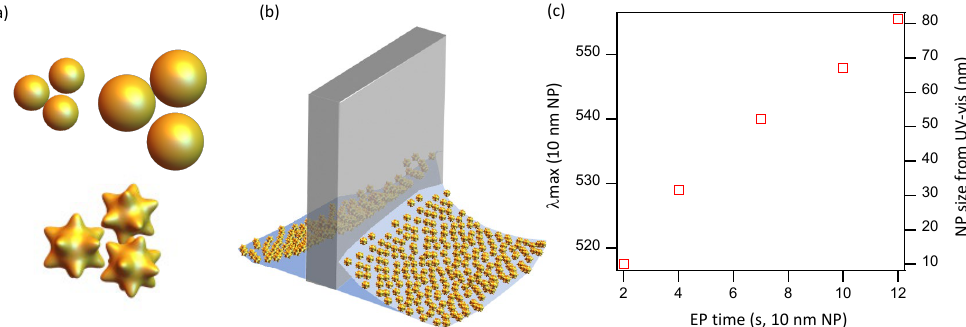
Figure 1. ( a ) Gold nanoparticles (NPs) of different spherical size or star-like shape are spread at the air/water interface and transferred onto a solid plate by means of the Langmuir–Blodgett technique ( b ). ( c ) Maxmimum wavelength of UV–vis absorption spectra of monolayers of 10nm gold NPs that act as seeds, after different gold electroless plating time. The spectrum is compared with that of gold NP of different sizes to provide with a rough estimation of the hotspot size.